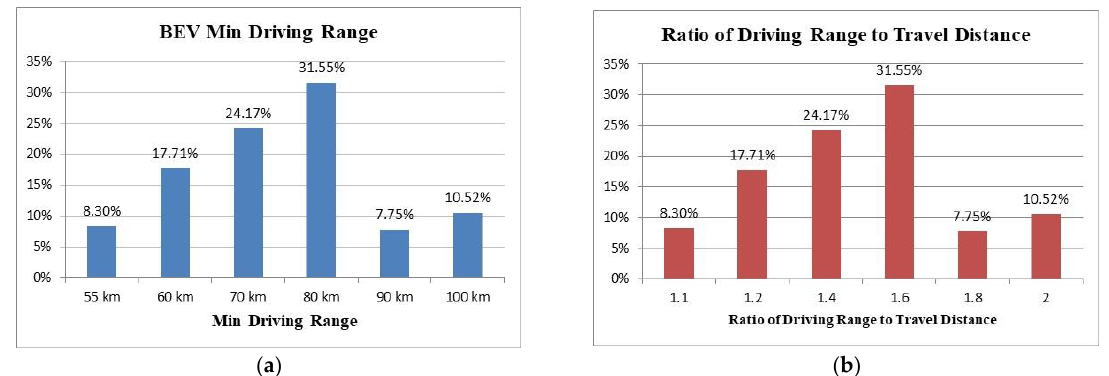
Figure 4. Distributions of min driving range and ratio of driving range to travel distance: ( a ) Min driving ranges; ( b ) Ratio of driving range to travel distance.